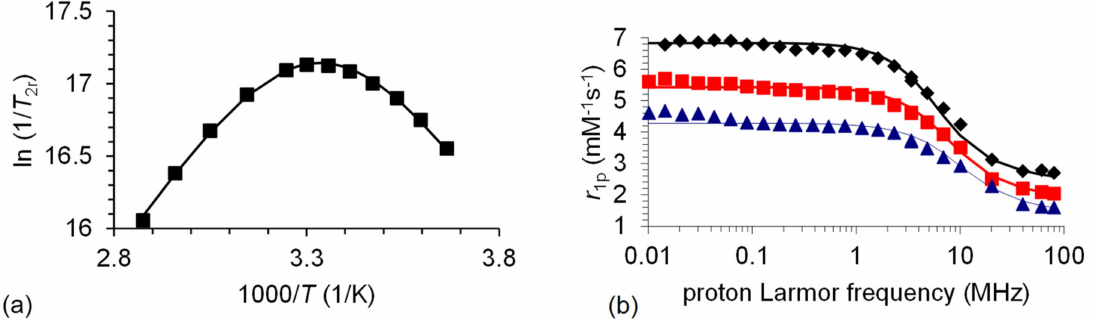
Figure 3. ( a ) Variable temperature reduced transverse 17 O relaxation rates (9.4 T) recorded for [Mn( 3,9- OPC2A )]. The line corresponds to the fits of the data. ( b ) 1 H NMRD profiles of [Mn( 3,9-OPC2A )] at 25 ( (cid:7) ), 37 ( (cid:4) ), and 50 ( (cid:78) ) ◦ C. The curves are the fitted